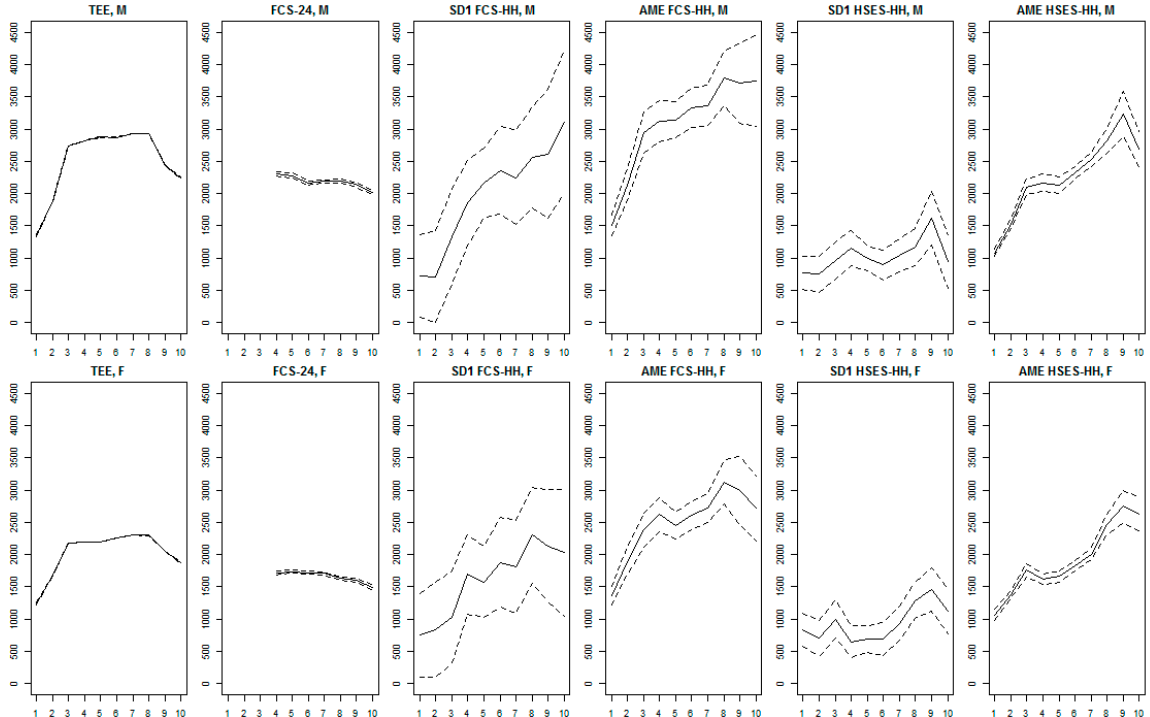
Figure 3. Comparison between mean daily estimated energy expenditure, observed dietary energy intake, and disaggregated household consumption estimates of individuals’ energy intake (kcal/day) across 10 age groups of males and females (Aims 2 and 3). y-axis : daily energy intake (kcal/day); x-axis : age groups 1–10 (1: 0 to 4 years, 2: 5–9, 3: 10–14, 4: 15–19, 5: 20–29, 6: 30–39, 7: 40–49, 8: 50–59, 9: 60–69, 10: 70+); row 1 : males (“M”); row 2 : females (“F”); column 1 : mean predicted total energy expenditure (“TEE”); column 2 : mean observed dietary energy intake from the FCS 24-h recall (“FCS-24”); column 3 : unadjusted statistical disaggregation of FCS-HH (“SD1 FCS-HH”); column 4 : adult male equivalent method (AME)-like statistical disaggregation of FCS-HH (“SD2 FCS-HH”); column 5 : AME disaggregation of FCS-HH (“AME FCS-HH”); column 6 : unadjusted statistical disaggregation of HSES-HH (“SD1 HSES-HH”); column 7 :